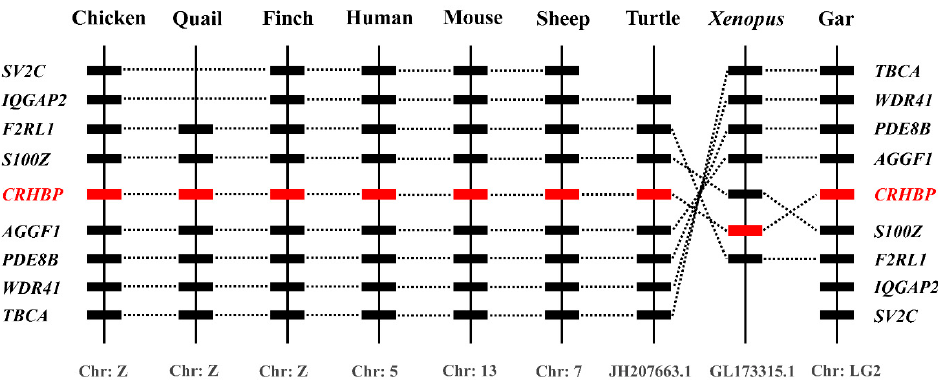
Figure 3. Synteny analyses of CRHBP in chickens and other vertebrates. CRHBP is localized in a distinct syntenic region conserved in chicken ( Gallus gallus ), quail ( Coturnix japonica ), finch ( Poephila guttata ), human ( Homo sapiens ), mouse ( Mus musculus ), sheep ( Ovis aries ), turtle ( Pelodiscus sinensis ), Xenopus ( Xenopus tropicalis ) and gar ( Lepisosteus oculatus ). Dotted lines indicate the syntenic genes identified in these species. Chr,